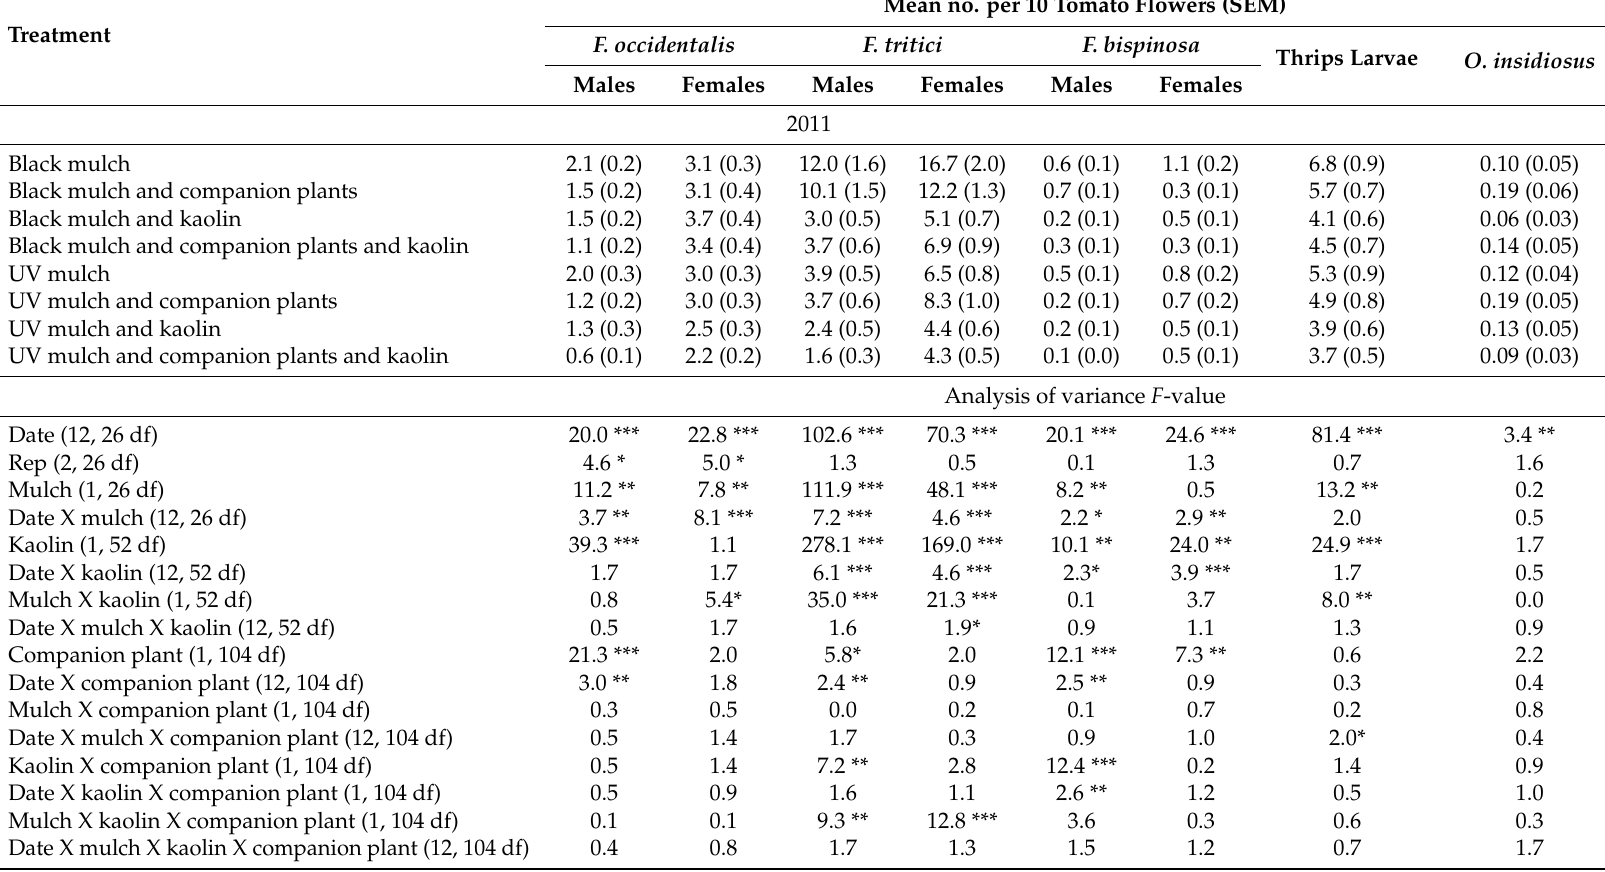
Table 1. Mean number per 10 tomato flowers (SEM) of adult male and female F. occidentalis , adult male and female F. tritici , adult male and female F. bispinosa , Frankliniella species larvae and total O. insidiosus (adults and nymphs) in mulch, kaolin and companion plant treatments for sample data pooled across 13 dates in 2011 ( n = 78) and 12 dates ( n = 72) in 2012 in push-pull experiments conducted in Gadsden County, Florida.